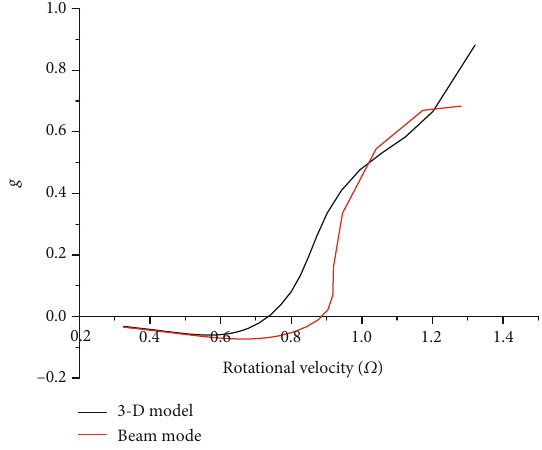
Figure 11: V-g diagram of the blade ( AR = 12 : 5 ).